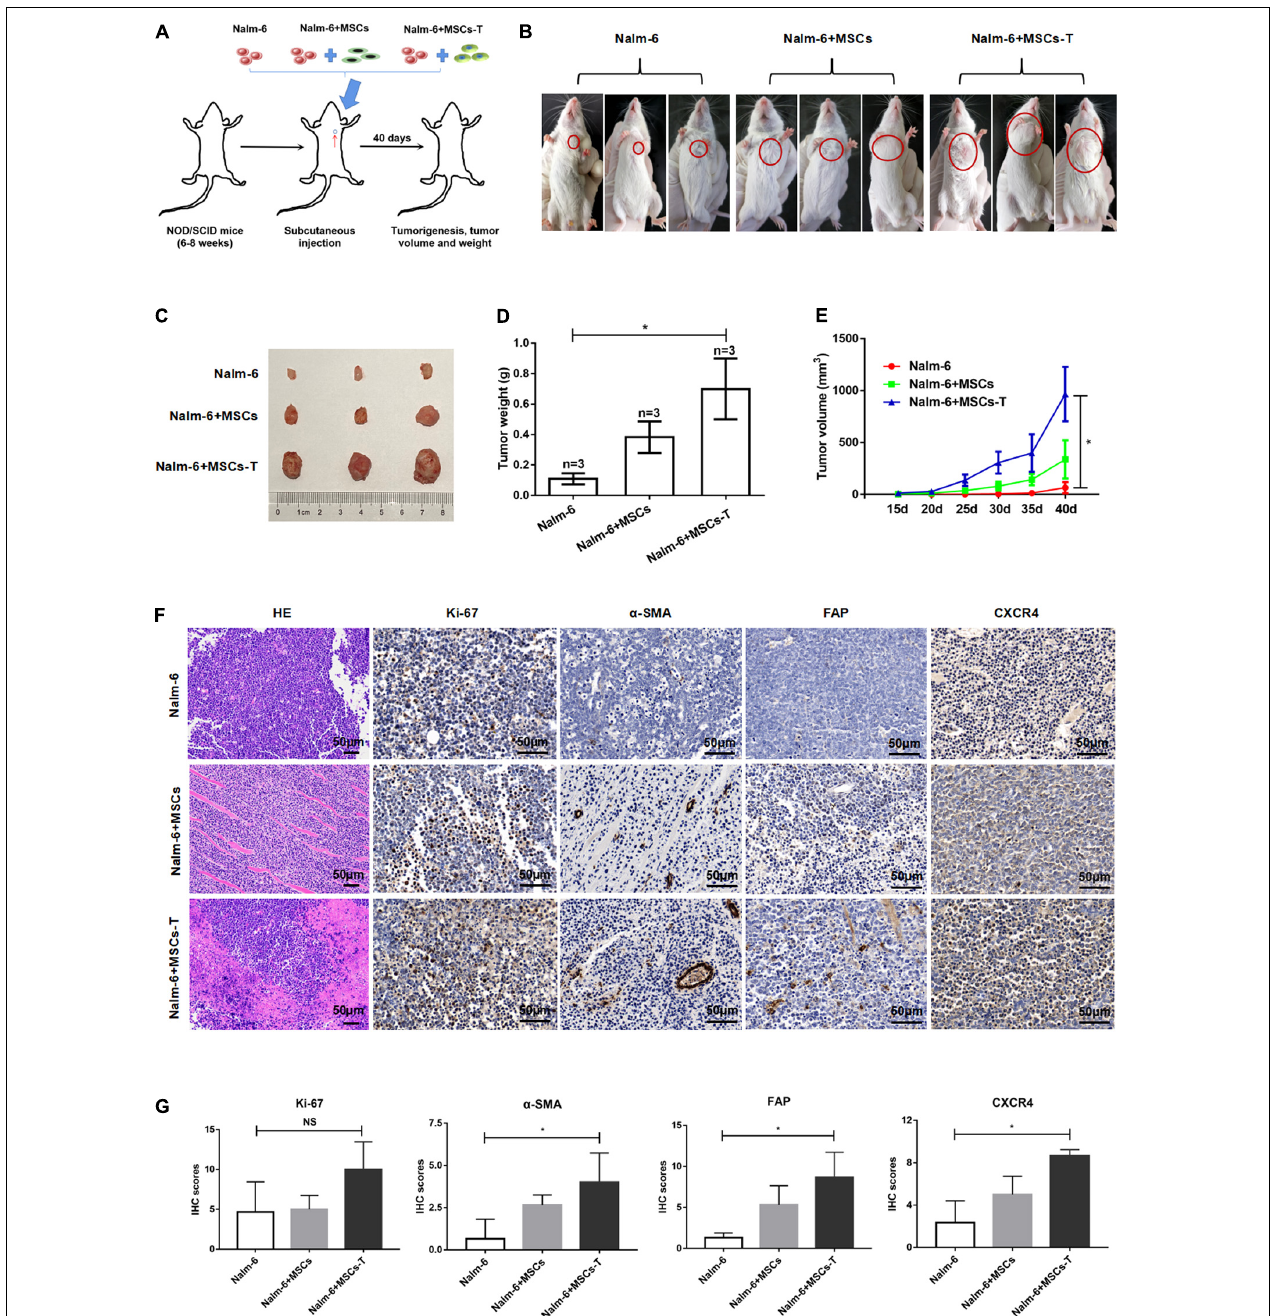
FIGURE 1 | Mesenchymal stem cells with CAF-like phenotype promoted the growth and proliferation of ALL cells in vivo . (A) Model of mouse subcutaneous tumor formation. (B,C) The size of subcutaneous tumors in the Nalm-6 injection group ( n = 3), Nalm-6 + MSCs injection group ( n = 3), and Nalm-6 + TGF- β conditioned MSCs (MSCs-T) injection group ( n = 3) after 40 days of growth. (D) Average tumor weight in each group was calculated at 40 days after injection. Error bars depict the mean ± SD. * P < 0.05. (E) Average tumor volume in each group, the difference of tumor volume between the three groups was evaluated at 40 days after injection. Error bars depict the mean ± SD. * P < 0.05. (F) HE staining (200 × ) of tumor tissue and the expression of Ki-67, α -SMA, FAP, and CXCR4 (400 × ) in xenotransplanted tumors with IHC (scale bars, 50 µ m). (G) The IHC scores of Ki-67, α -SMA, FAP and CXCR4 in each group. NS, no significant statistical